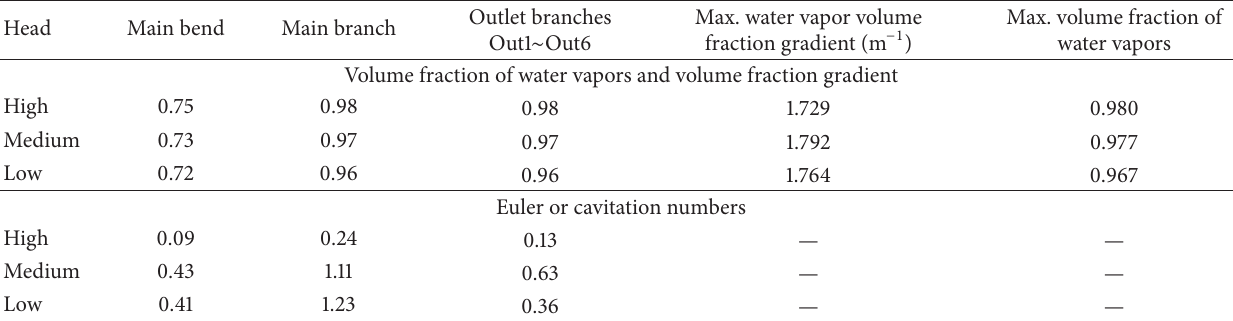
Table 11: Volume fraction of water vapors and volume fraction gradient in Tunnel 2 under various head conditions.